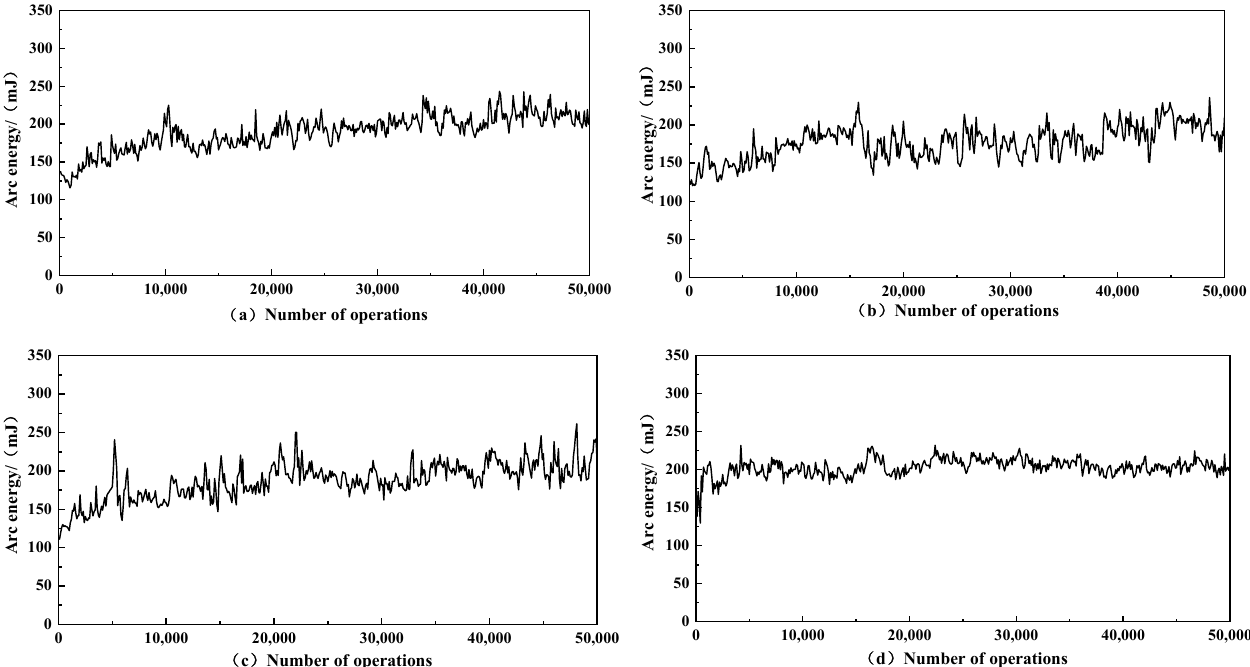
Figure 5. Ag-graphene/Ni contactor arc energy: ( a ) AgNi15-5 mg GO, ( b ) AgNi15-10 mg GO, ( c ) AgNi15-20 mg GO, ( d ) AgNi15. Table 3. Average arc energy and variance of the Ag-graphene/Ni.